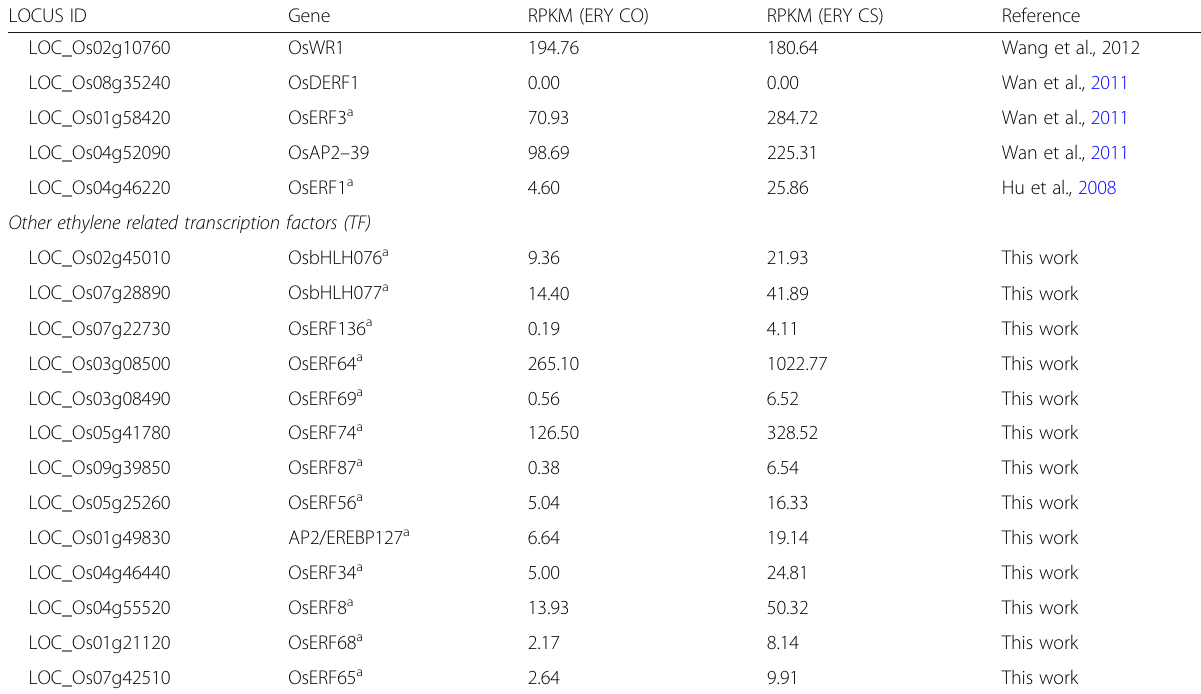
Table 1 Cold-stress responses of ethylene metabolism-related genes in tolerant rice anthers. [this table should be added immediately before Discussion] (Continued) LOCUS ID